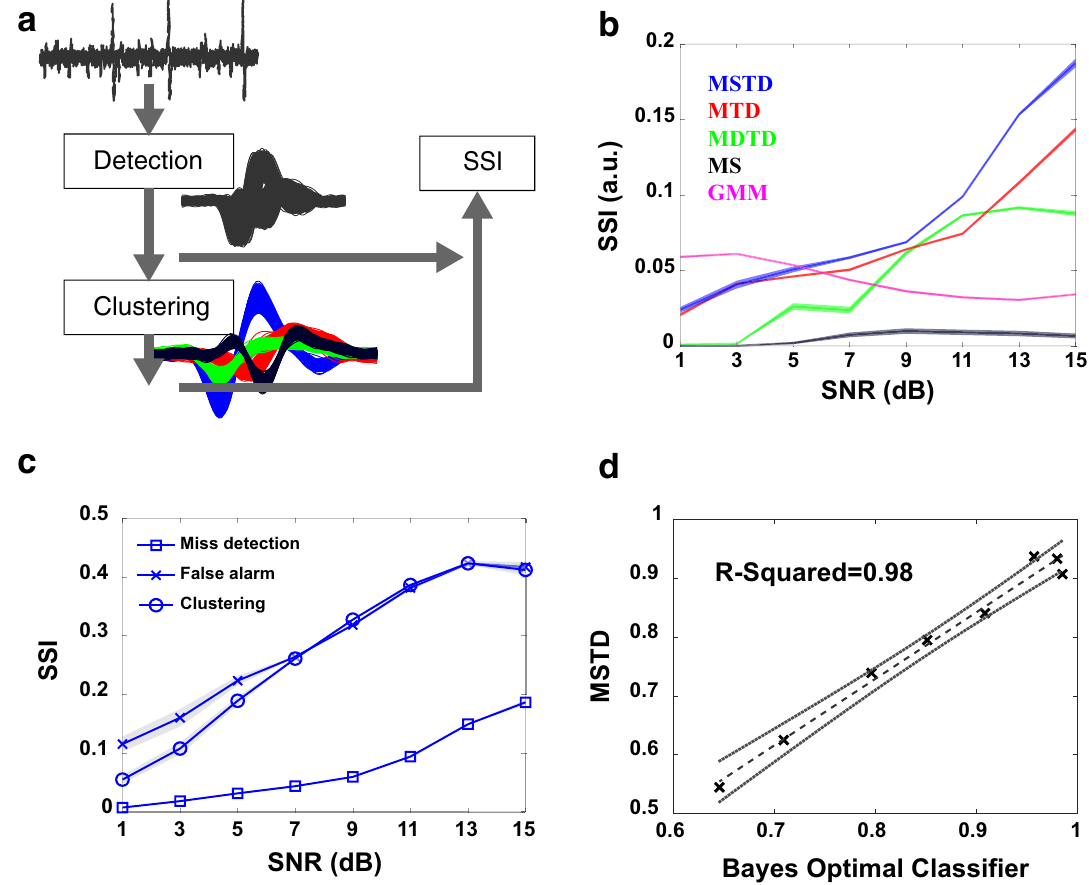
Figure 3. Comparison of the MSTD performance with four state-of-the-art spike sorting algorithms. Results are obtained using the synthesized dataset. ( a ) Illustration of the SSI metric. It considers both detection and clustering outputs integrated into a single value. ( b ) Comparison of the proposed fully automatic spike sorting algorithm with four state-of-the-art algorithms employing SSI. The shaded area is the standard error. The proposed MSTD algorithm outperforms all other compared algorithms considering both detection and clustering performances, simultaneously. Only for SNRs lower than 5 dB, GMM has a better performance than the proposed algorithm. ( c ) The effect of miss detection, false alarm, and clustering performance on SSI. The MSTD algorithm has the lowest performance in terms of miss detection. ( d ) CA-CA plot between MSTD and the Bayes optimal classifier to investigate the robustness of the proposed method. The R-squared of the fitted line with the least square method is